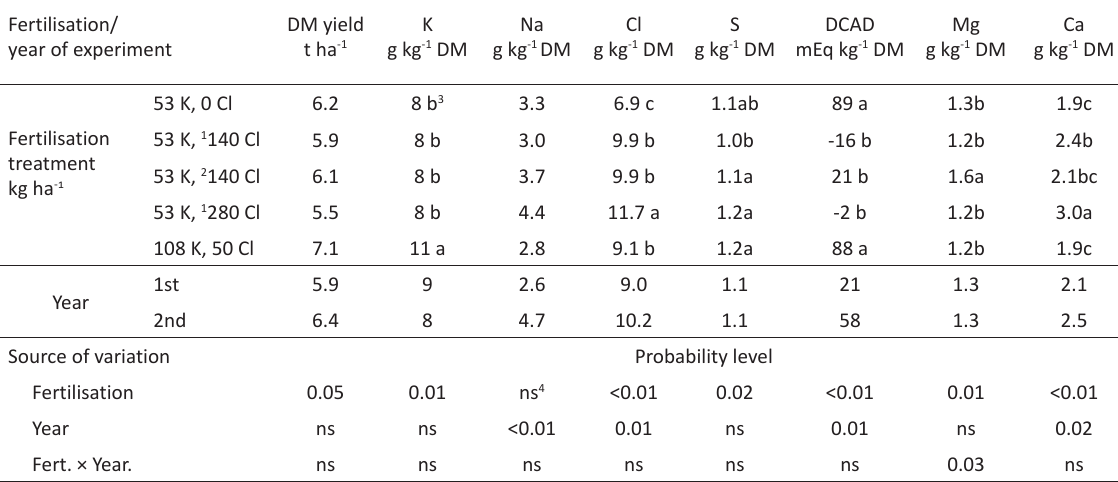
Table 3. Experiment 2: Forage dry matter yield, dietary cation-anion difference (DCAD) and mineral concentrations at the first cut. Effects of calcium chloride, magnesium chloride and potassium fertilisation on leys dominated by timothy and meadow fescue. Average of one field trial at Vigra in two